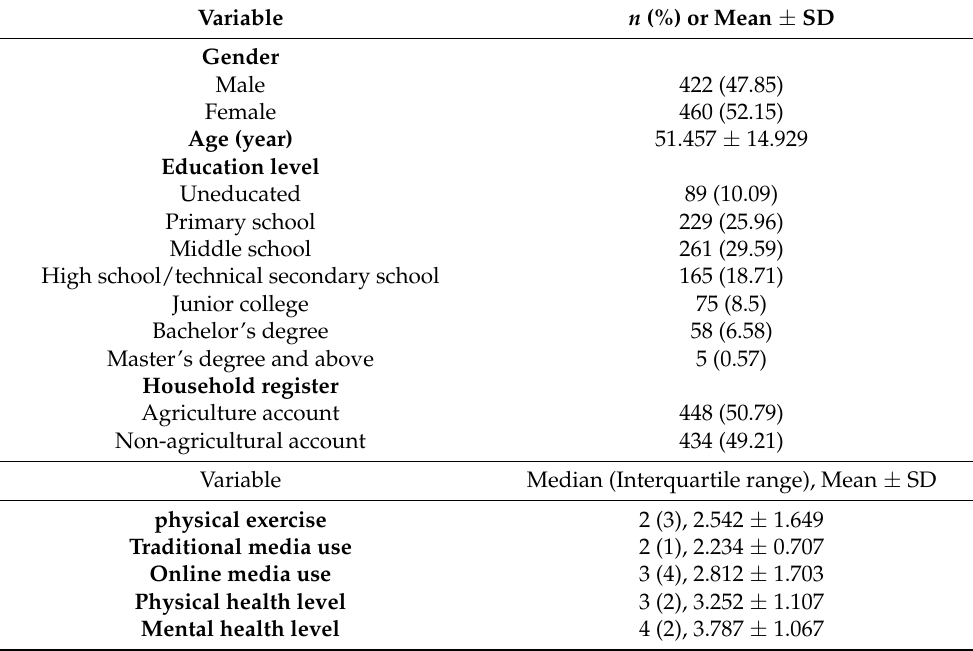
Table 1. Sociodemographic information of the participants ( n = 882).